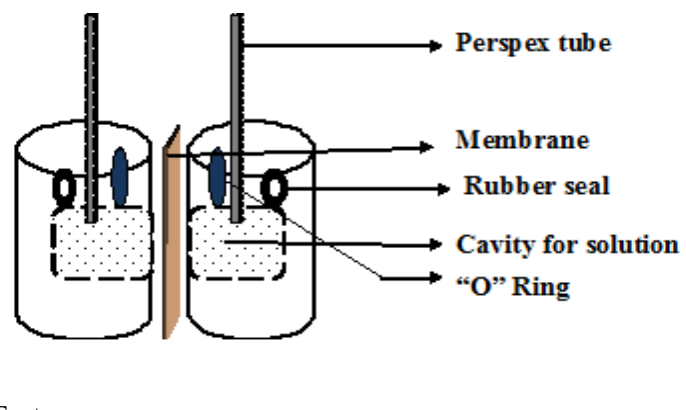
Figure 3 . Schematic showing water transfer test cell (Adapted from